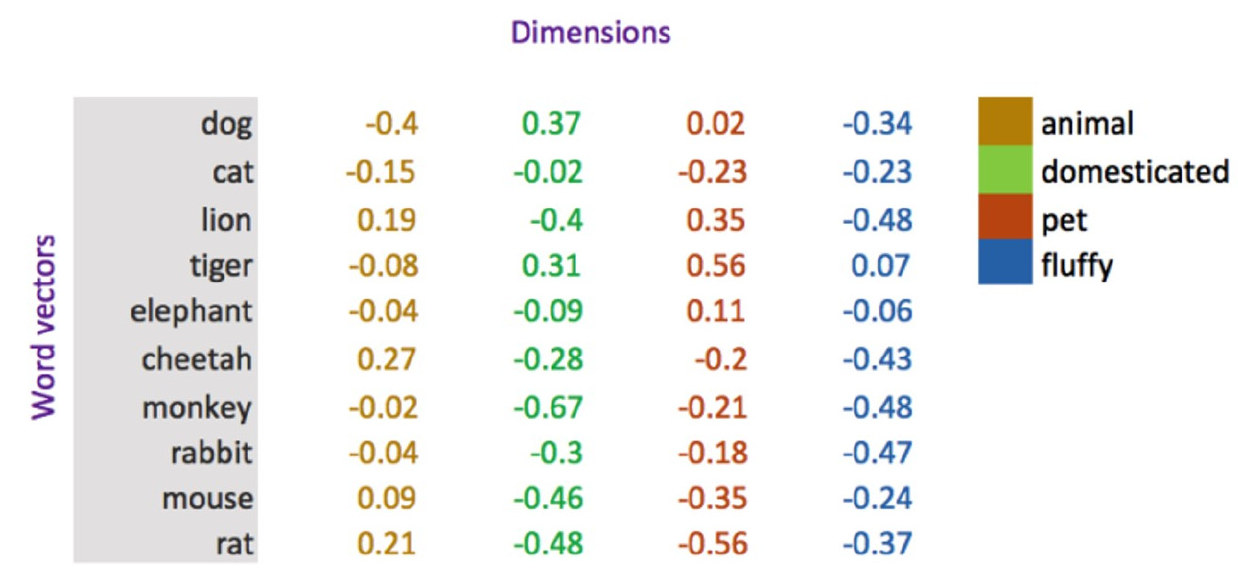
5 of 29 Table 1. Simplified representation of textual corpus dimensionality.